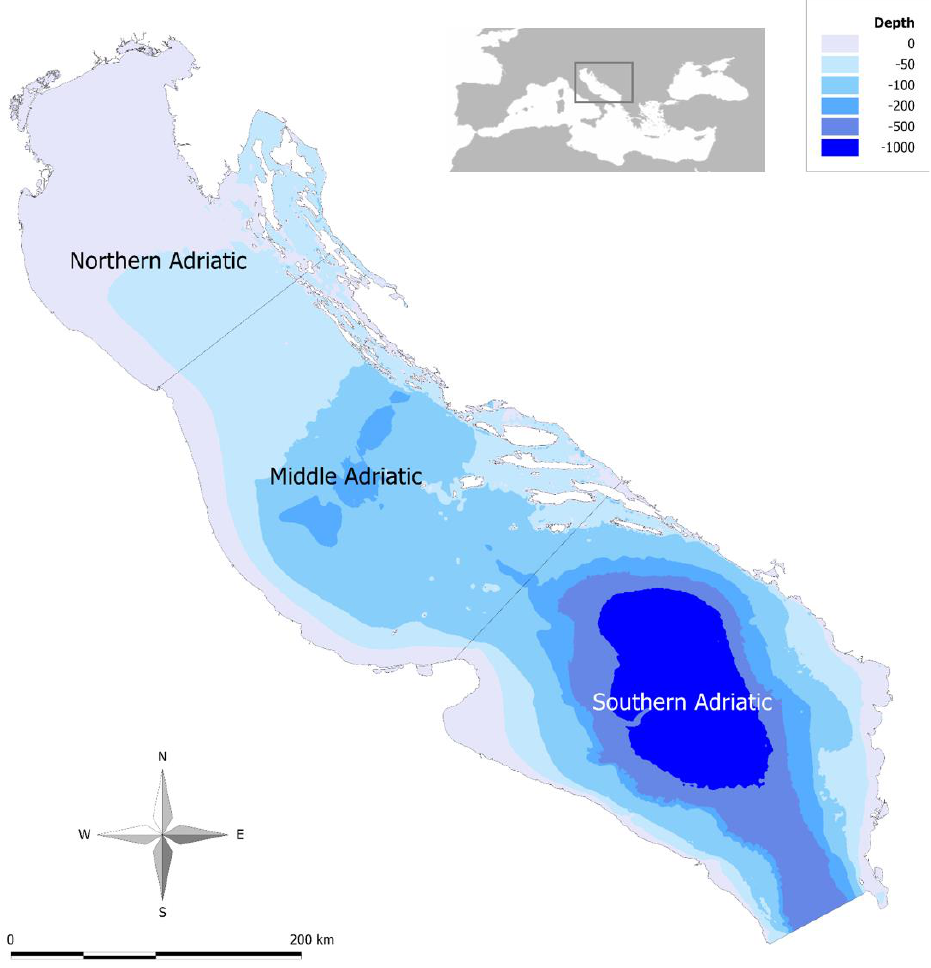
Figure 1. The division of the Adriatic Sea and its position in the Mediterranean Basin.